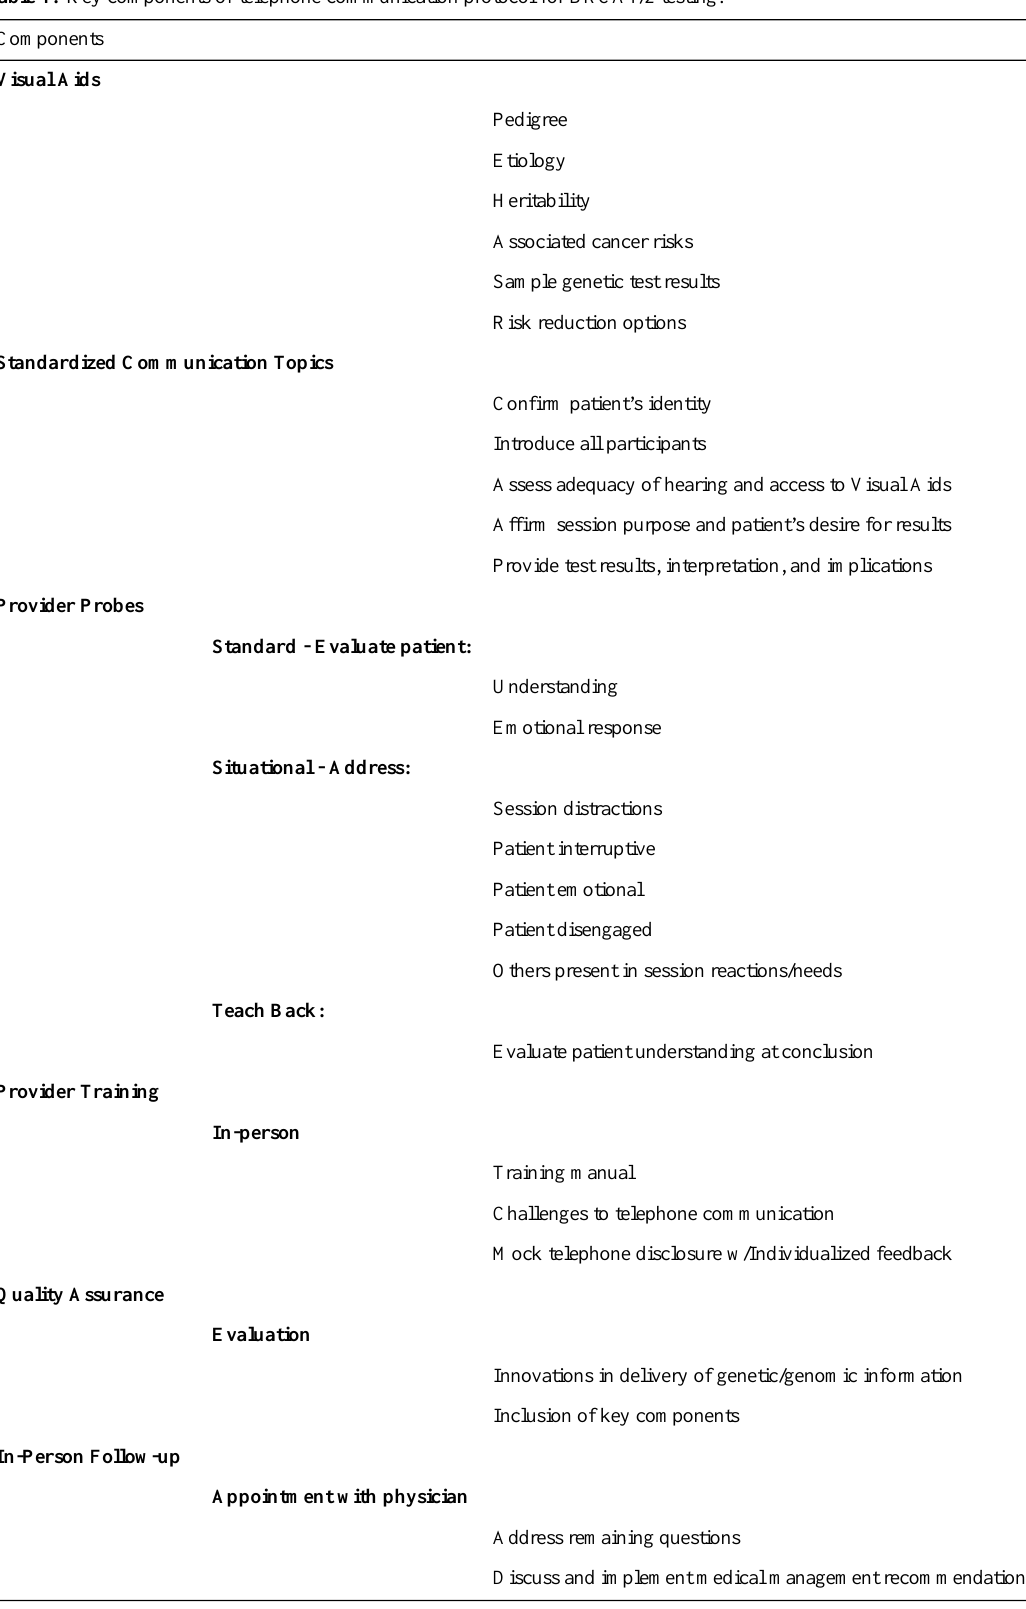
Table 1. Key components of telephone communication protocol for BRCA1/2